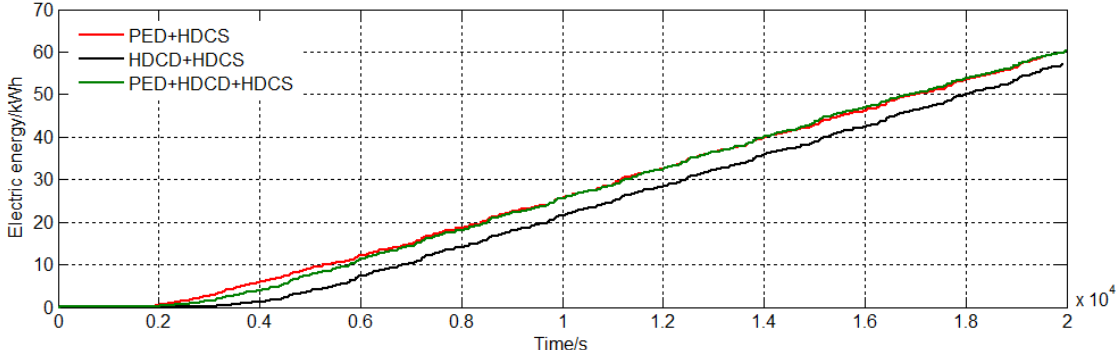
Figure 19. The electric energy profiles from regeneration braking under different